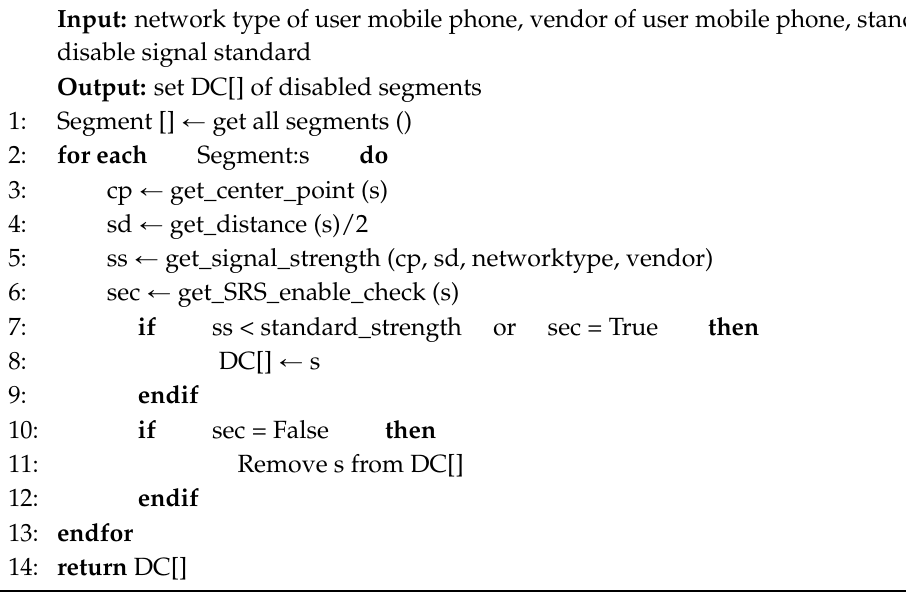
Algorithm 1. disabled_coverage_measuring (network type, vendor, standard_strength)